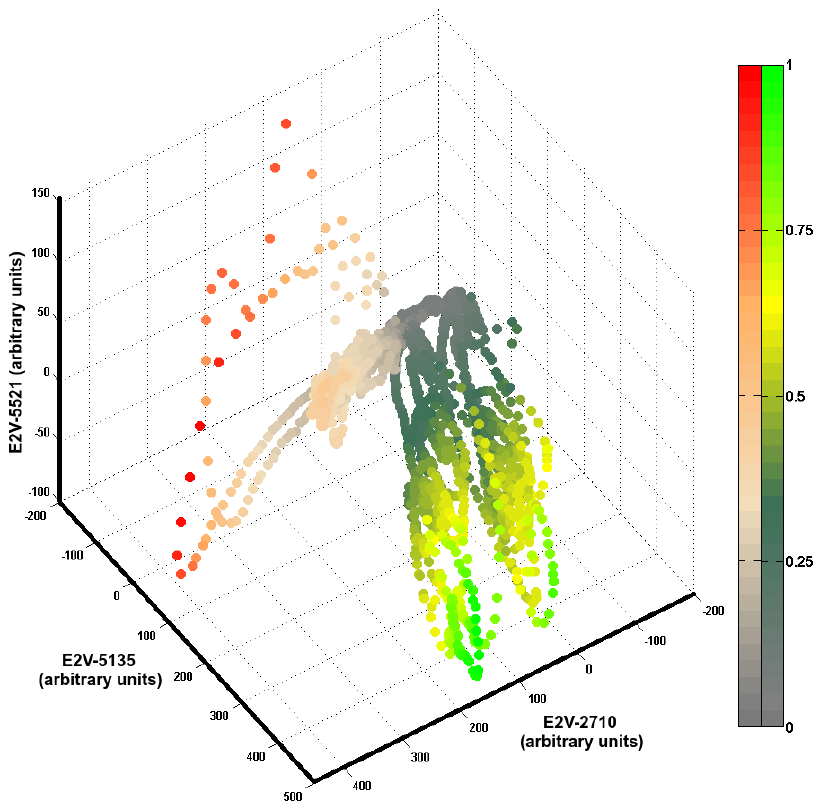
Figure 2. Feature space for a two class gas discrimination problem. Each data point represents the instantaneous concentration measurement acquired with a sensor array composed of 3 sensors. The color shades denote the normalized concentration level. Green shades are assigned to ethanol samples, while red shades are assigned to propanol samples. The axes units represent the baseline corrected sensor